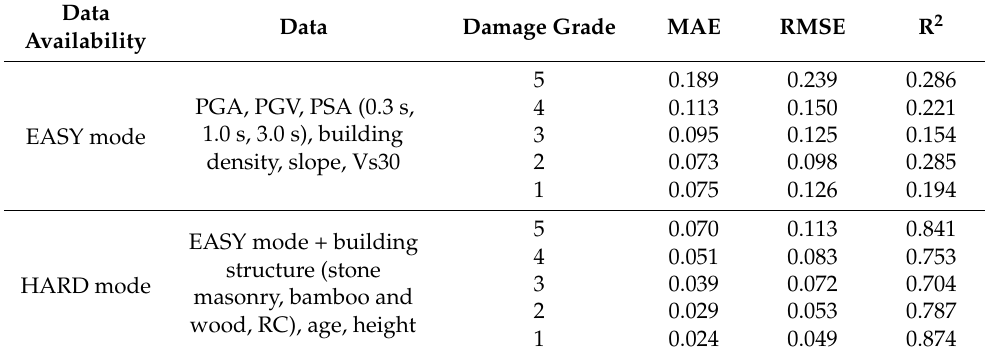
Table 5. Evaluation of microzone-level building damage assessment with different feature combinations.